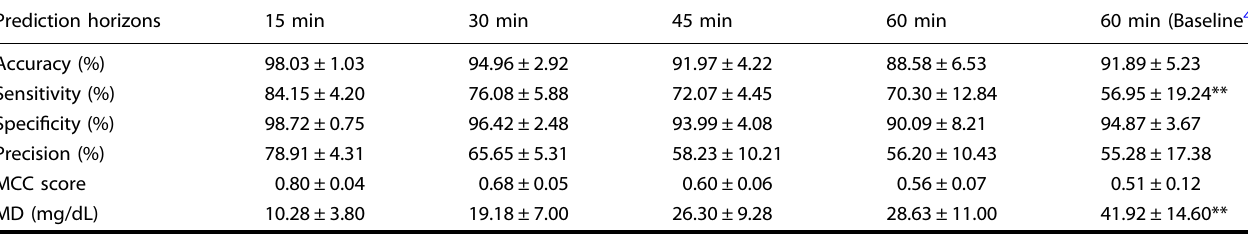
Table 3. Results of hypoglycemia prediction (Mean ± SD) evaluated on 12 clinical T1D subject. Prediction